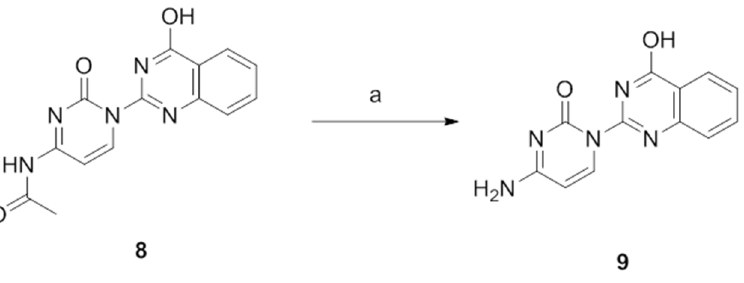
Figure 5. Deprotection of compound 8 . Reagents and conditions: (a) methylamine solution (40%), 65 °C, 24 h.